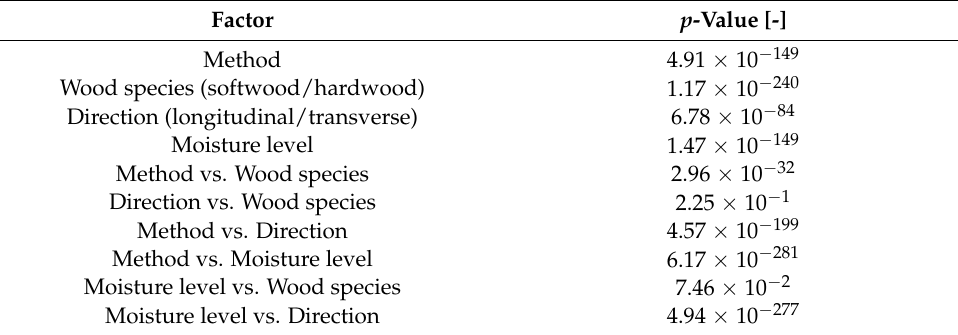
Table 2. Results of multivariate ANOVA. Factor interactions are marked with an abbr.